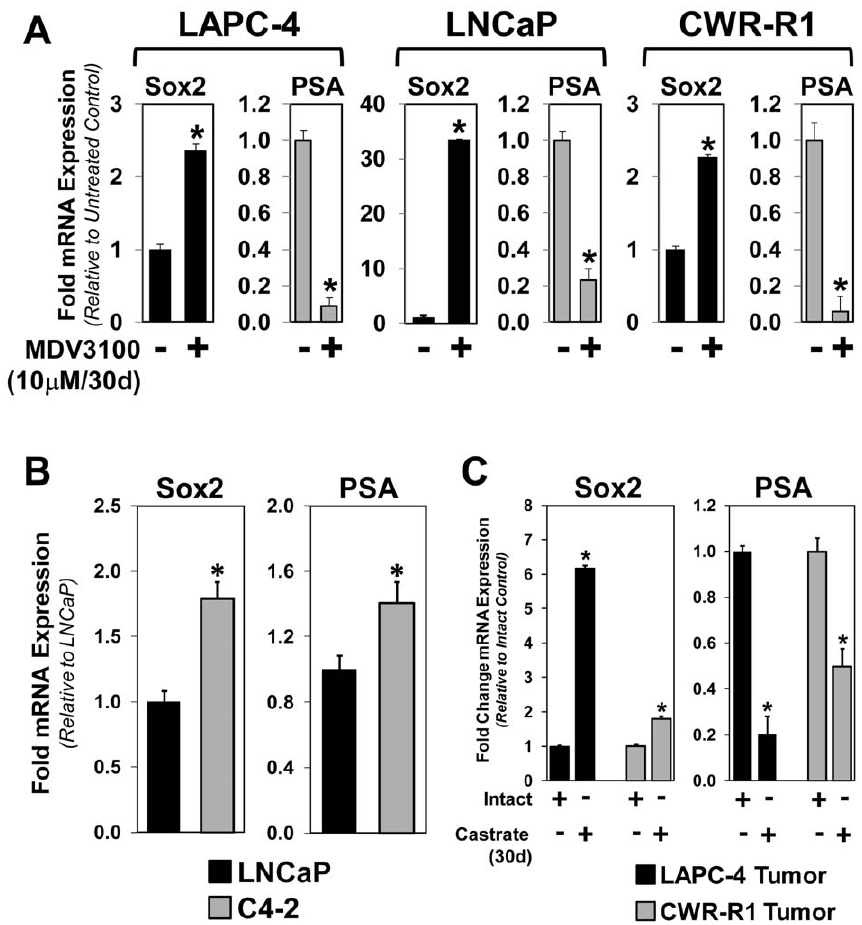
Figure 6. Sox2 expression is increased in MDV3100-resistant prostate cancer cells and castration-resistant prostate tumors. A ) To test whether Sox2 expression is associated with resistance to AR pathway inhibition, we developed a series of prostate cancer cell lines that were resistant to MDV3100. After 30 days of continuous treatment, MDV3100-resistant lines expressed significantly higher Sox2 as measured using qPCR (*p , 0.05). AR-mediated PSA expression was also significantly reduced in these lines. B ) Comparison between the castration-sensitive LNCaP and isogenic castration-resistant C4-2 cell lines documents a significant increase in Sox2 expression in castration-resistant C4-2 cells (*p , 0.05). C ) Increased Sox2 expression in castration-resistant xenografts of LAPC-4 and CWR-R1 tumors. Tumors were allowed to establish and then host mice were castrated; 30 days later castration-resistant tumors were harvested and total mRNA analyzed for Sox2 and PSA. These data show increased Sox2 within castration-resistant LAPC-4 and CWR-R1 tumors (*p , 0.05; data represents quantitation from multiple tumor